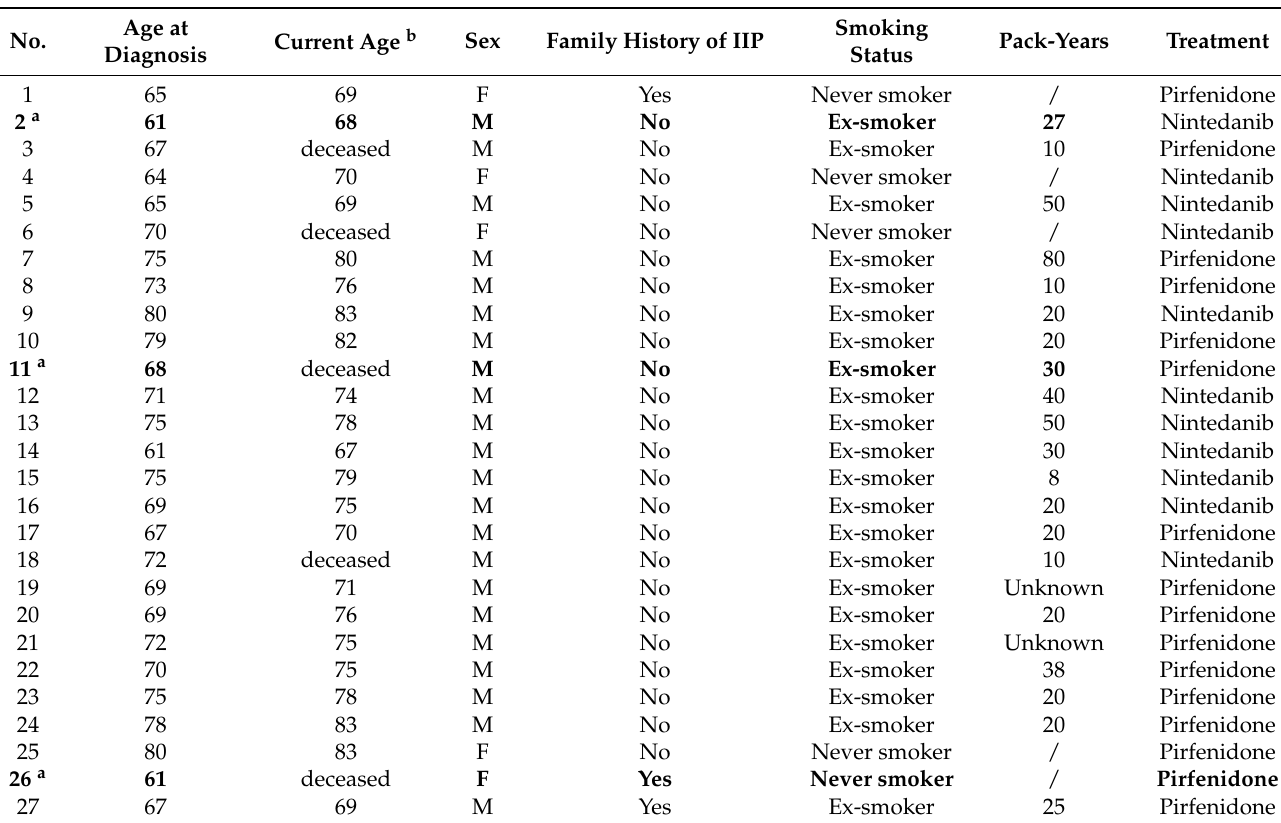
Table 1. Demographic and clinical data of IPF patients.